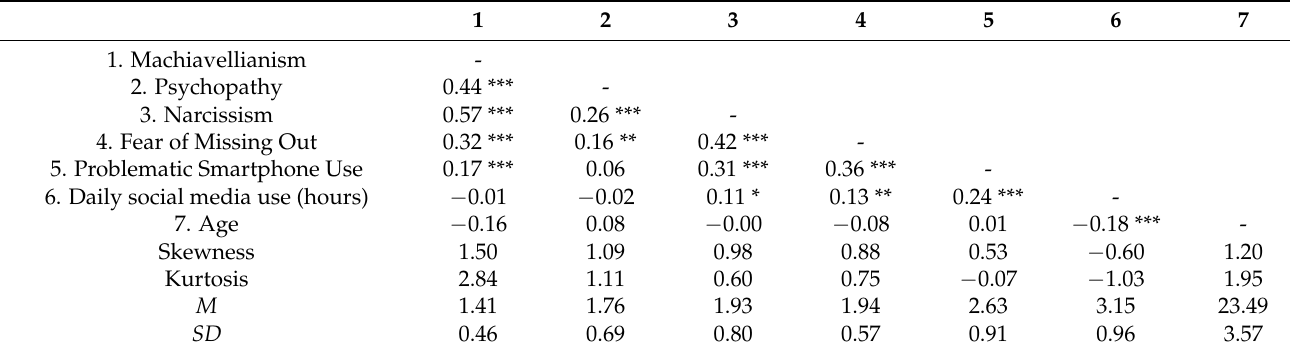
Table 1. Pearson’s correlations and descriptive statistics of the study variables among the full sample.